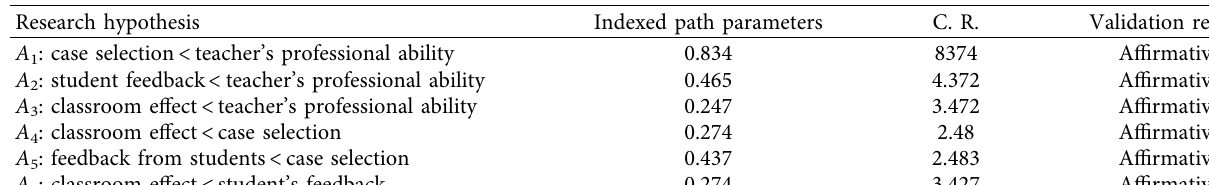
Figure 5: Comparison of model fitting indexes. Table 4: Specific verification results of research hypotheses.